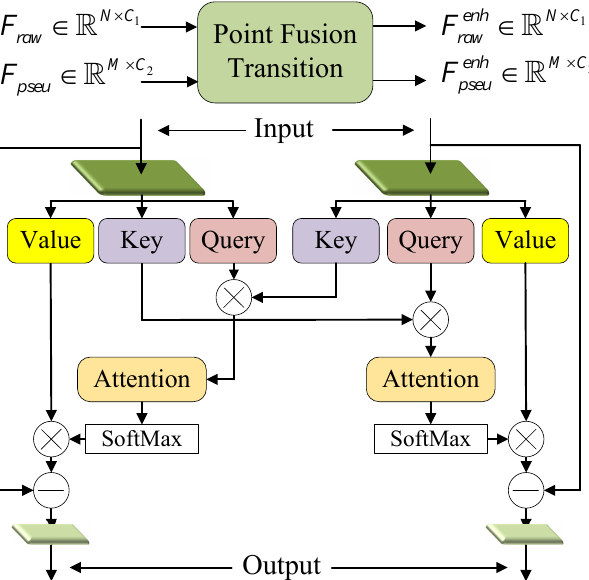
Figure 6. Illustration of PFT. It is employed to perform bi-directional information exchange between two point-based features from different